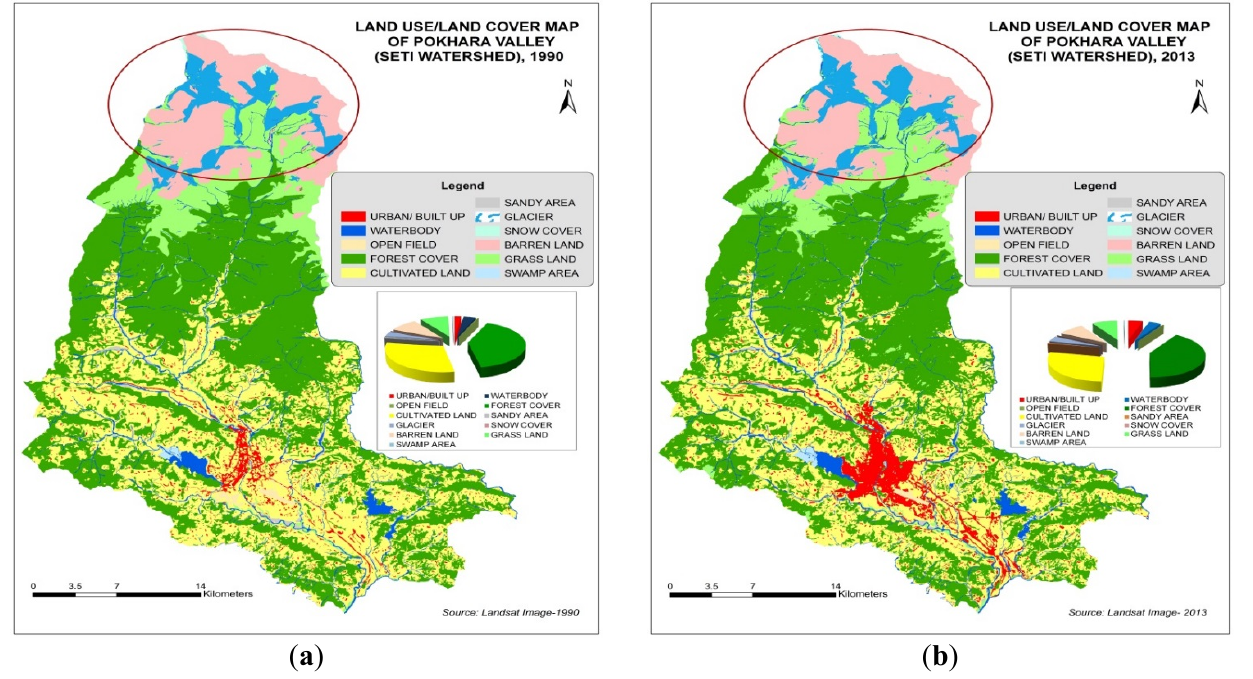
Figure 4. ( a ) LULC map of Pokhara valley, 1990; ( b ) LULC map of Pokhara valley,